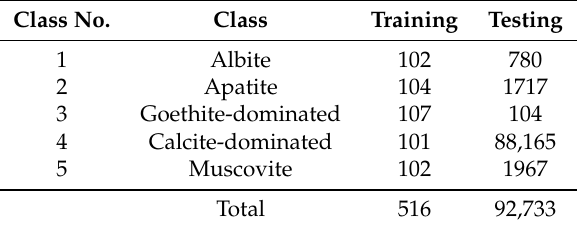
Table 4. The numbers of training and test samples used for the classification purpose on the RZ2 dataset. Class No. Class